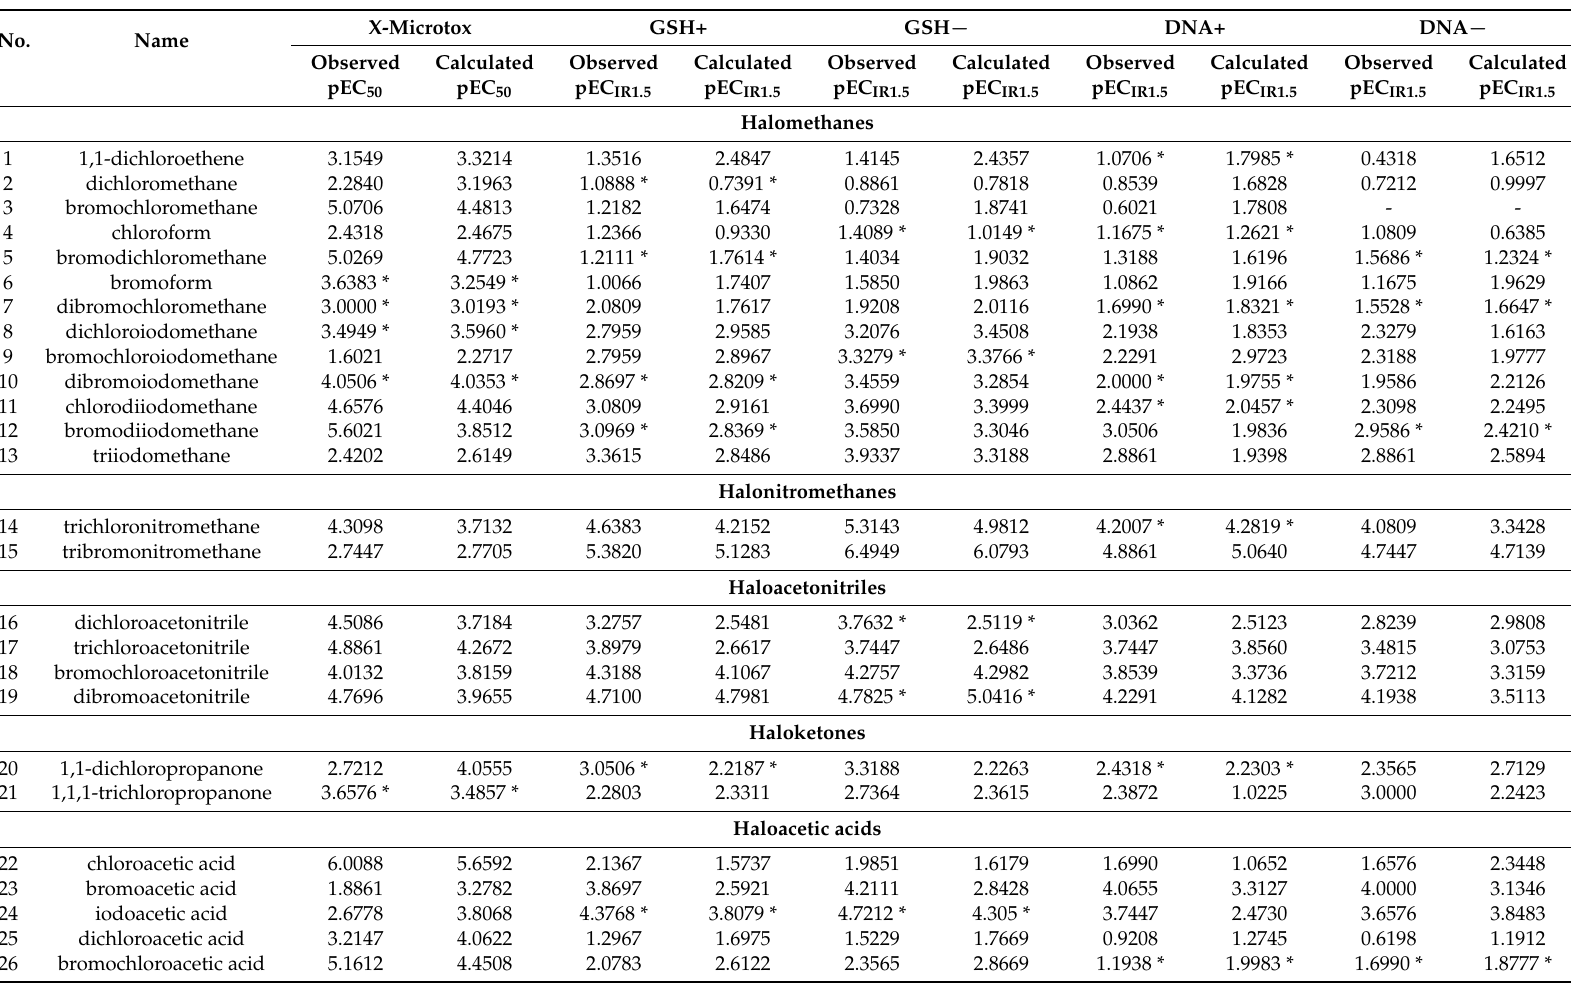
Table 2. Observed and calculated effect concentrations (pEC 50 (negative logarithm of 50% effective concentration) for X-Microtox and pEC IR1.5 (negative logarithm of 1.5 induction ratio effective concentration) for the other assays, mol/L) of disinfection